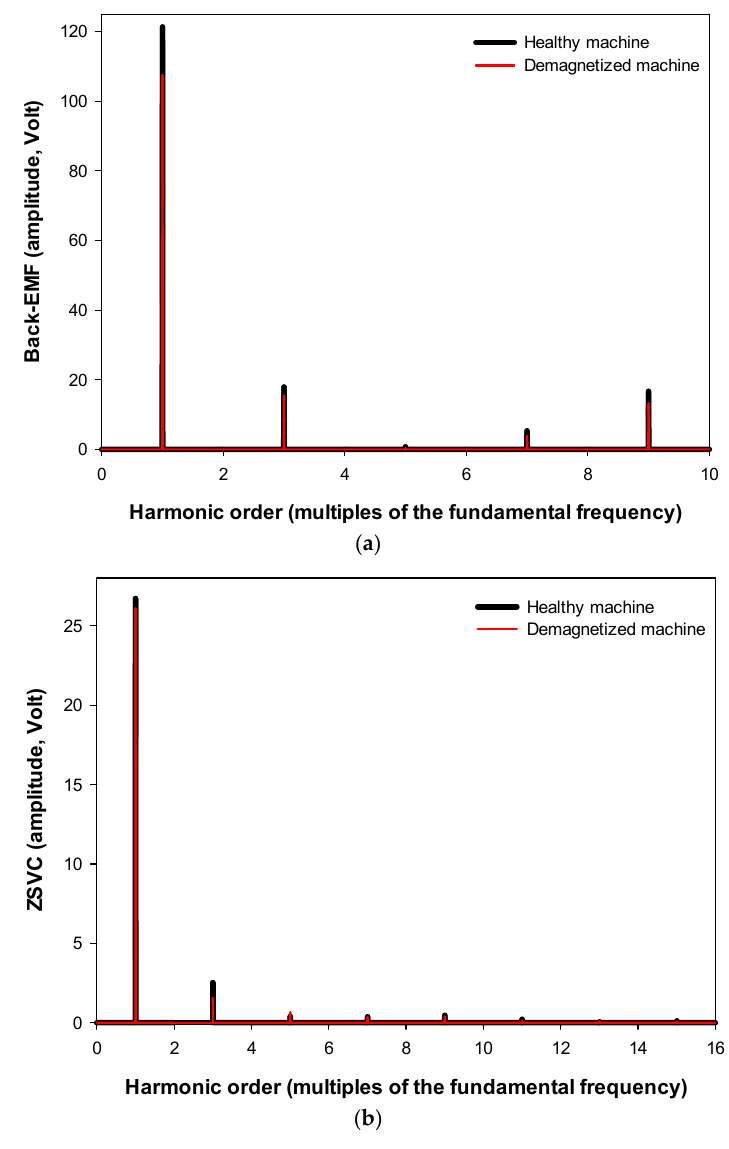
Figure 6. Back-EMF ( a ) and ZSVC ( b ) spectra of a healthy and a partially demagnetized machine (two adjacent north magnetic poles 100% demagnetized).